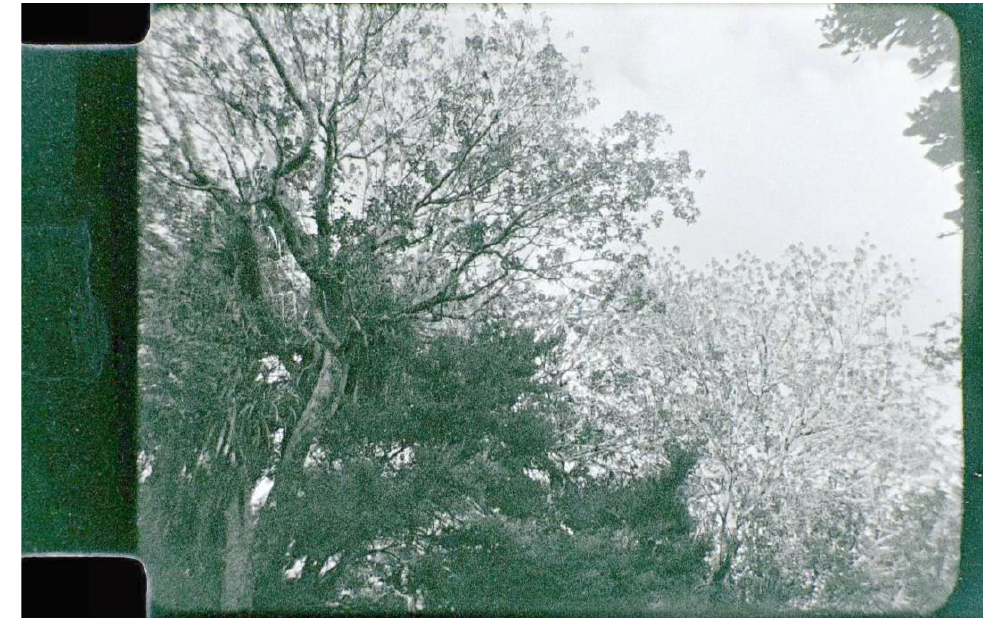
Figure 5. Nova Paul, Hawaiki , 2022, 16mm film print.